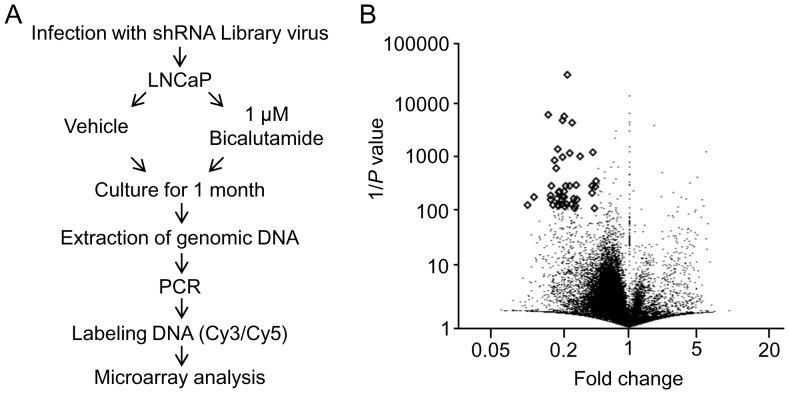
Screening for bicalutamide response-related genes in prostate cancer cells.(A) Schematic representation of shRNA screening. LNCaP cells were infected with a lentiviral shRNA library and further cultured with or without bicalutamide for 1 month. Individual integrated shRNA amounts were quantified by microarray. (B) Volcano plot of microarray data, as generated by clustering based on probes that were enriched or depleted (fold change <0.5; P<0.01) in bicalutamide-treated cells compared to vehicle-treated cells.